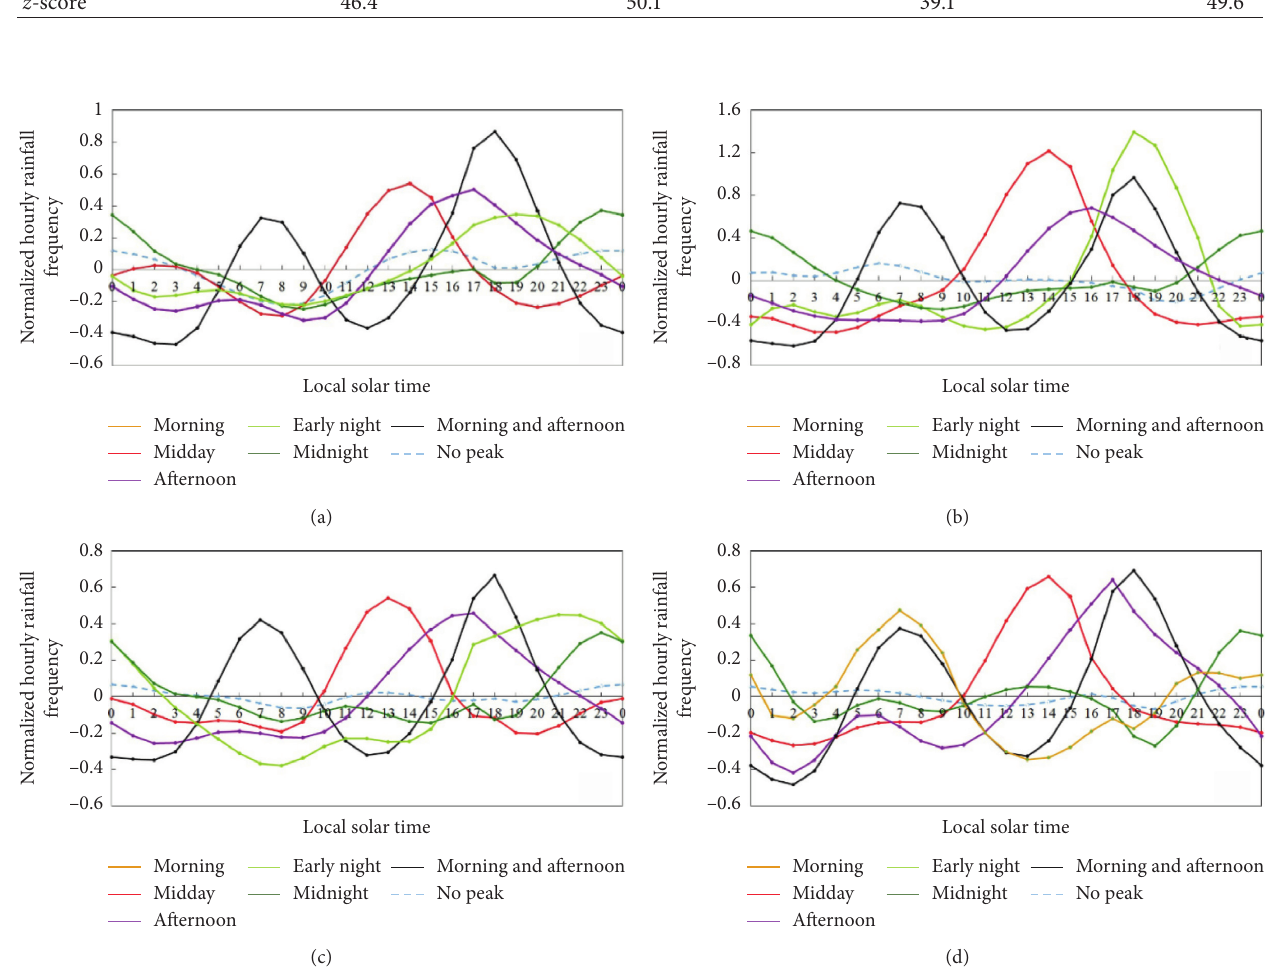
Figure 5: Curve of normalized hourly precipitation frequency corresponding to each type of diurnal variation in Figure 4: (a) for spring, (b) for summer, (c) for autumn, and (d) for